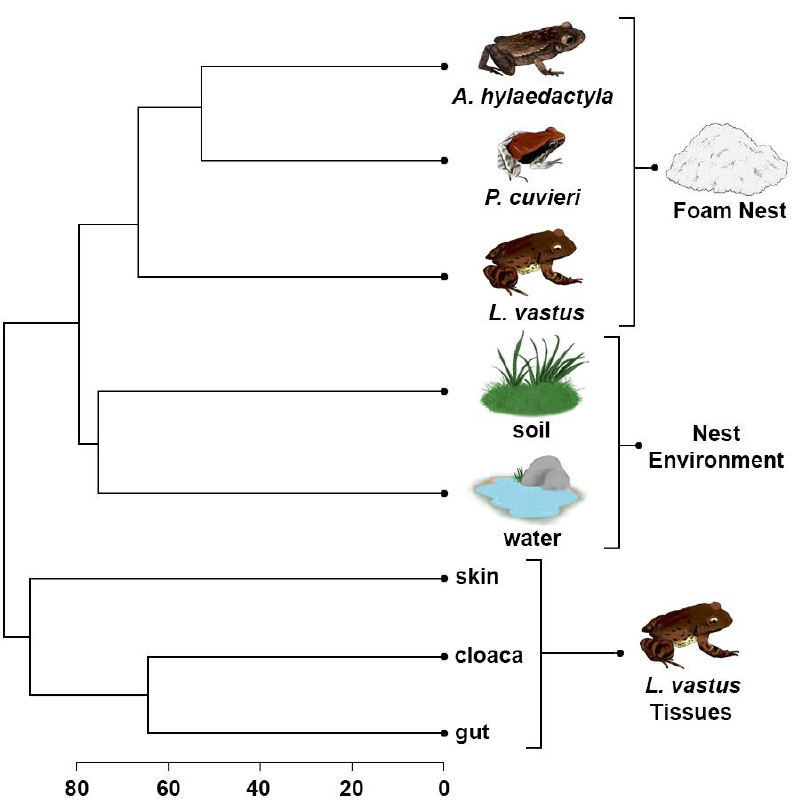
Figure 7. UPGMA cluster based on Bray–Curtis dissimilarities between bacterial amplicon sequence variants at the genus level presents in the foam nests, nest environments, and tissues of L. vastus .